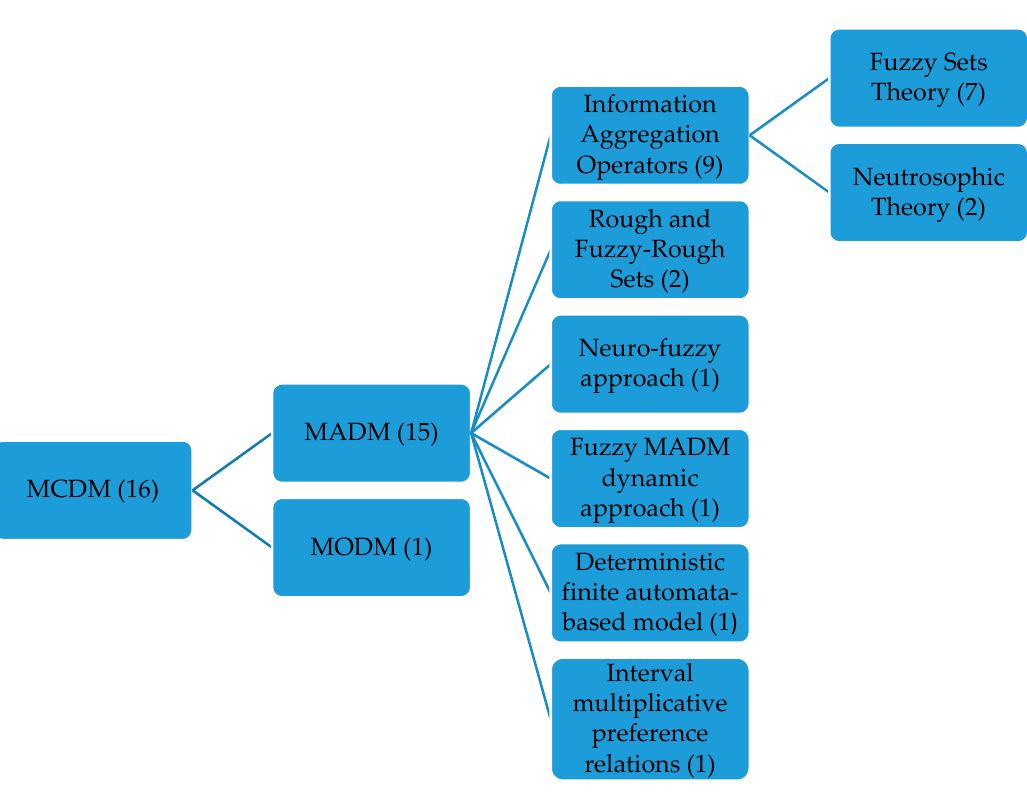
Figure 2. Decision-making approaches.